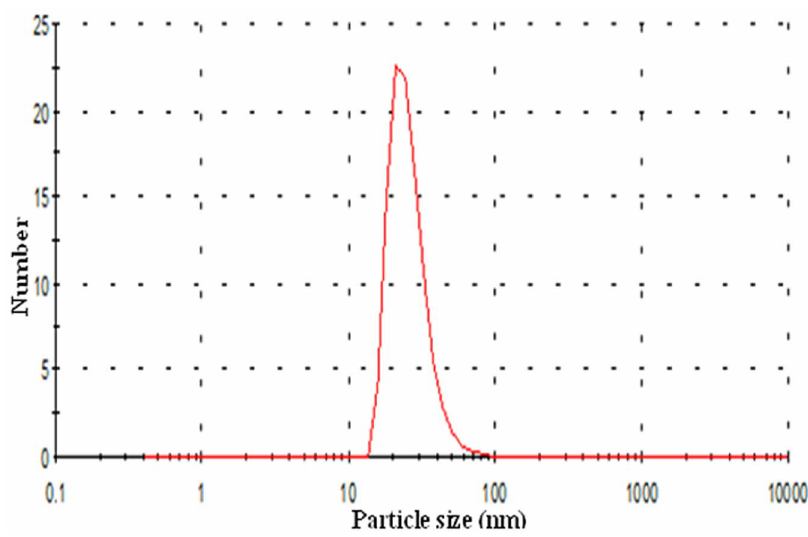
Figure 4. Graph showing particle size distribution by number for synthesized MNPs that was obtained by particle size analyzer. As shown from the observed peak the size of MNPs is 25.8 nm.